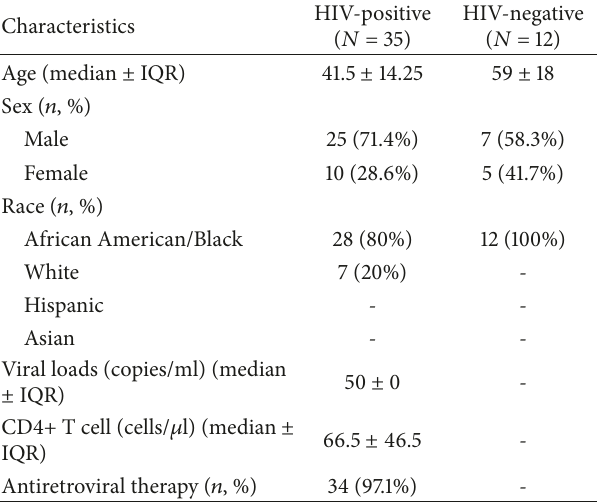
Table 1: Patient